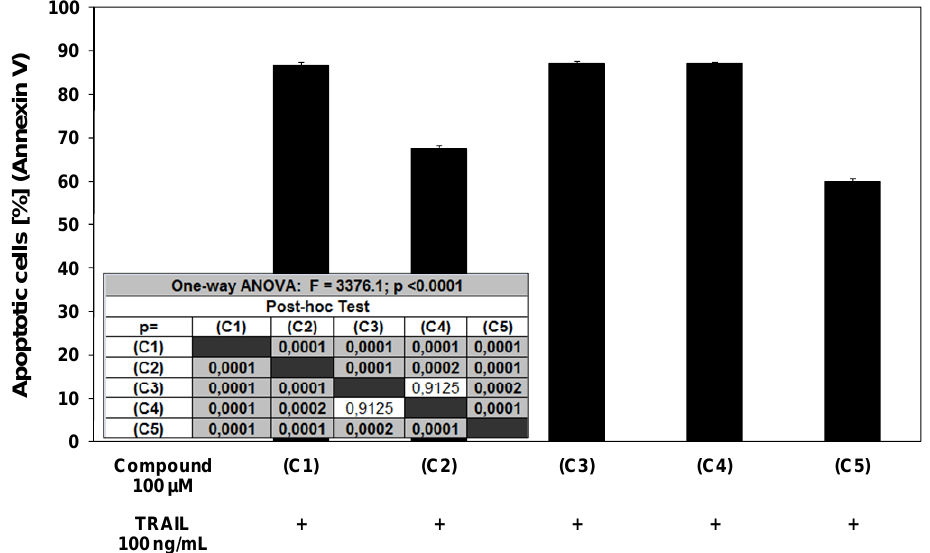
Figure 7. Statistical analysis of apoptotic activity of TRAIL in combination with chalcones and dihydrochalcones in LNCaP prostate cancer cells. The data are expressed as mean ±SD (n = 6) (p < 0.05).